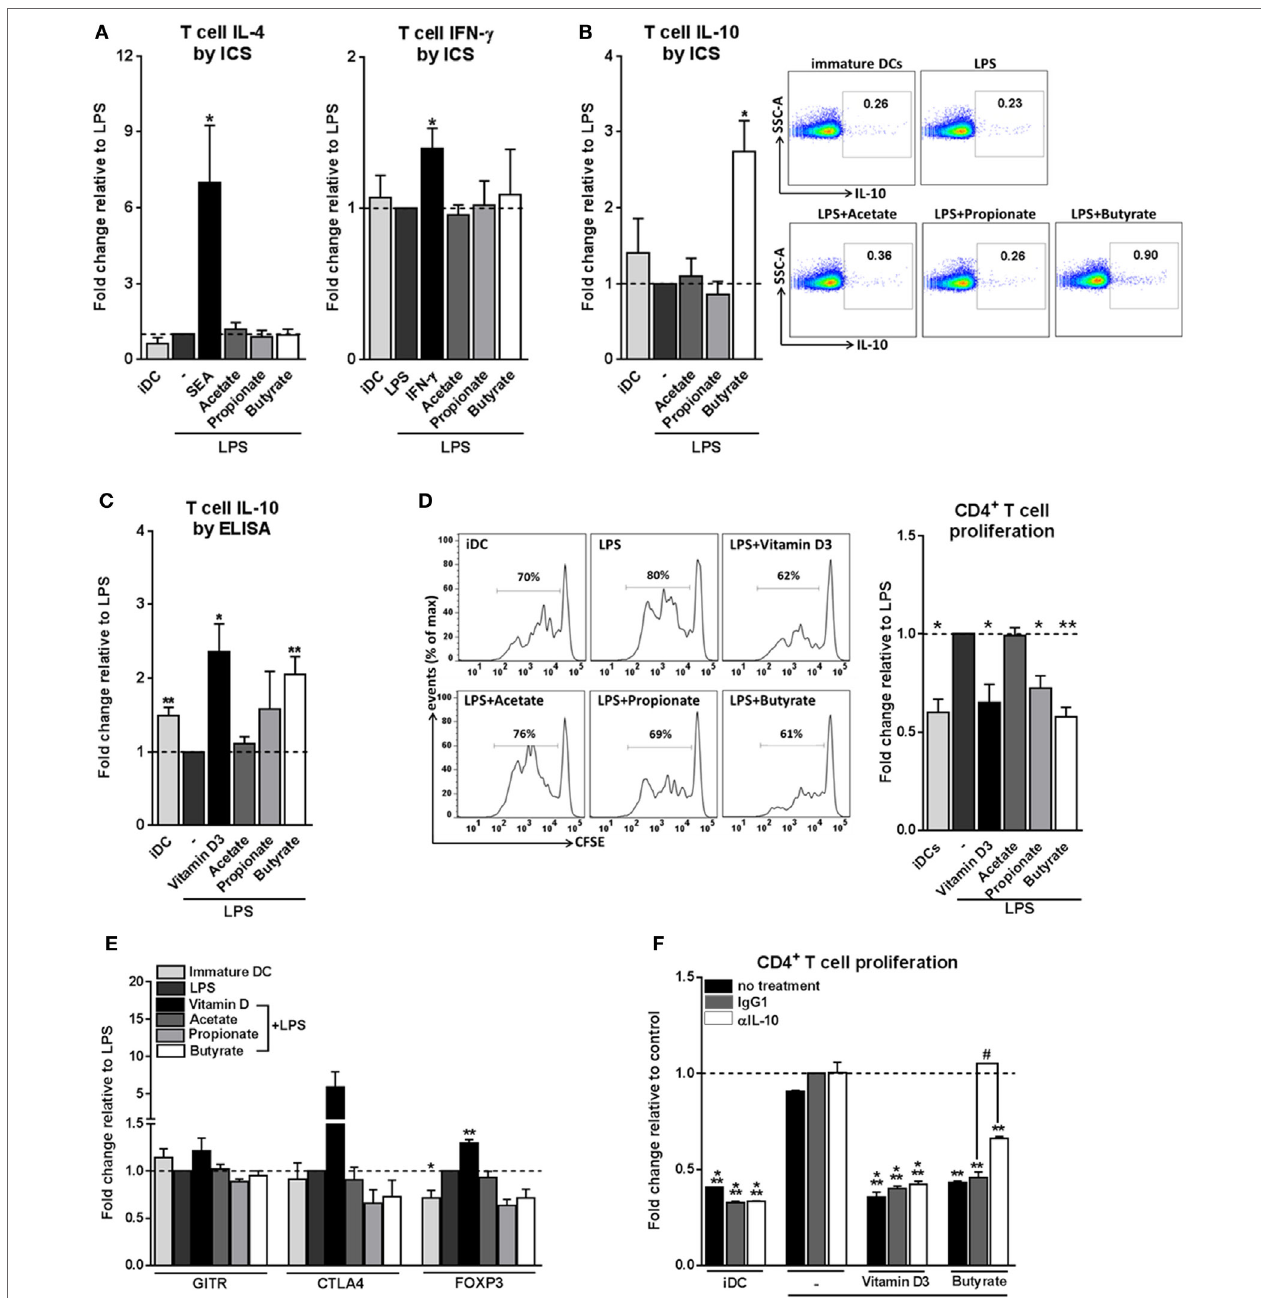
FigUre 2 | Butyrate conditions human dendritic cells (DCs) to induce type 1 regulatory T cells. (a–c) Differently stimulated DCs were cocultured with allogenic naive CD4 + T cells. After 11 days, cytokine production by T cells was analyzed (a,B) by intracellular cytokine staining by flow cytometry after 6 h of stimulation with PMA and ionomycin or (c) by ELISA after 24 h restimulation with anti-CD3/CD28. (a–c) Data represent fold change in panels (a,B) percentage of T cells that stain positive for indicated cytokines or in panel (c) IL-10 levels in culture supernatants, relative to data from LPS-stimulated DCs which was set to 1 for each cytokine (dashed line). (B) Representative flow cytometry plots are shown on the right. (D) T-cell suppression assay in which irradiated test T cells were cocultured with activated CFSE-labeled responder CD4 + T cells. On day 6, CFSE dilution of the responder T cells was assessed by flow cytometry. The left panels are representative histograms of CFSE dilution by responder T cells. Quantification of these data is shown in the bar graph and is depicted as fold change relative to data from LPS-stimulated DCs, which was set to 1 (dashed line). (e) Expression of regulatory markers by T cells was analyzed by flow cytometry. Bar graphs represent relative differences based on geometric mean fluorescence for glucocorticoid induced TNF receptor (GITR) and cytotoxic T-lymphocyte-associated protein 4 (CTLA4) or frequency of T cells that express forkhead box P3 (FOXP3). (F) For the duration of the assay as described in panel (D) indicated antibodies were added. Data are from one experiment representative of two, shown as means ± SEM of triplicates. (a–e) Bar graphs represent means ± SEM of at least three experiments. *,# p < 0.05, ** p < 0.01, *** p < 0.001 for significant differences with the control (*) or between test conditions ( # ) based on paired Student’s t